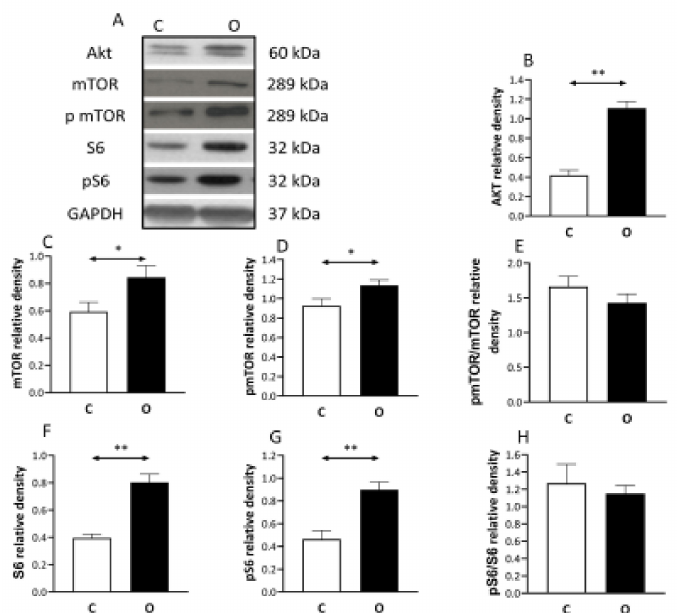
Figure 2. Pro anabolic pathway during muscle hypertrophy. Overload induce muscle hypertrophy increases the contents of pro-anabolic Akt, mechanistic target of rapamycin mTOR (mTOR) and ribosomal protein S6 kinase (S6 kinase) compared to control muscle, suggesting the significant involvement of this signaling pathway. ( A ) panel shows the selected immunoplot signals, and ( B – H ) panels show the densitometric results of nine samples in each group. C: control group, O: Overloaded group, n = 9, * p <0.05, ** p < 0.01, Results are expressed as mean ± SE.